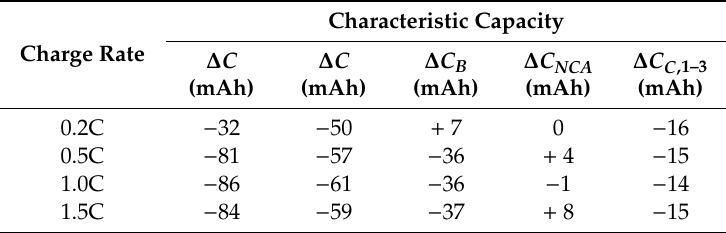
Table A2. Change of characteristic capacities after load cycle 1 at 10 ◦ C.